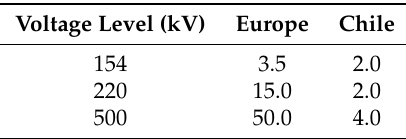
Table 1. Short-circuit levels (GVA) in Chile and Europe